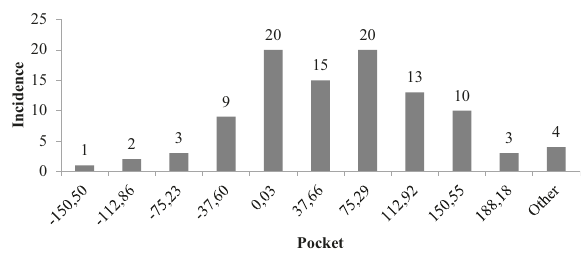
Fig. 7 Probabilistic assessment of implementing the recommendations on change management with the help of the Monte Carlo method. Source : calculated and compiled by the